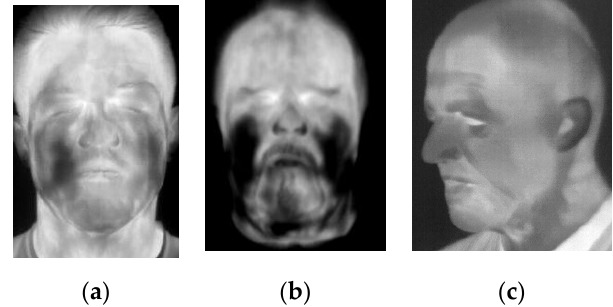
Figure 8. Sample images used during validation: ( a , b ) genuine subjects classified as a presentation